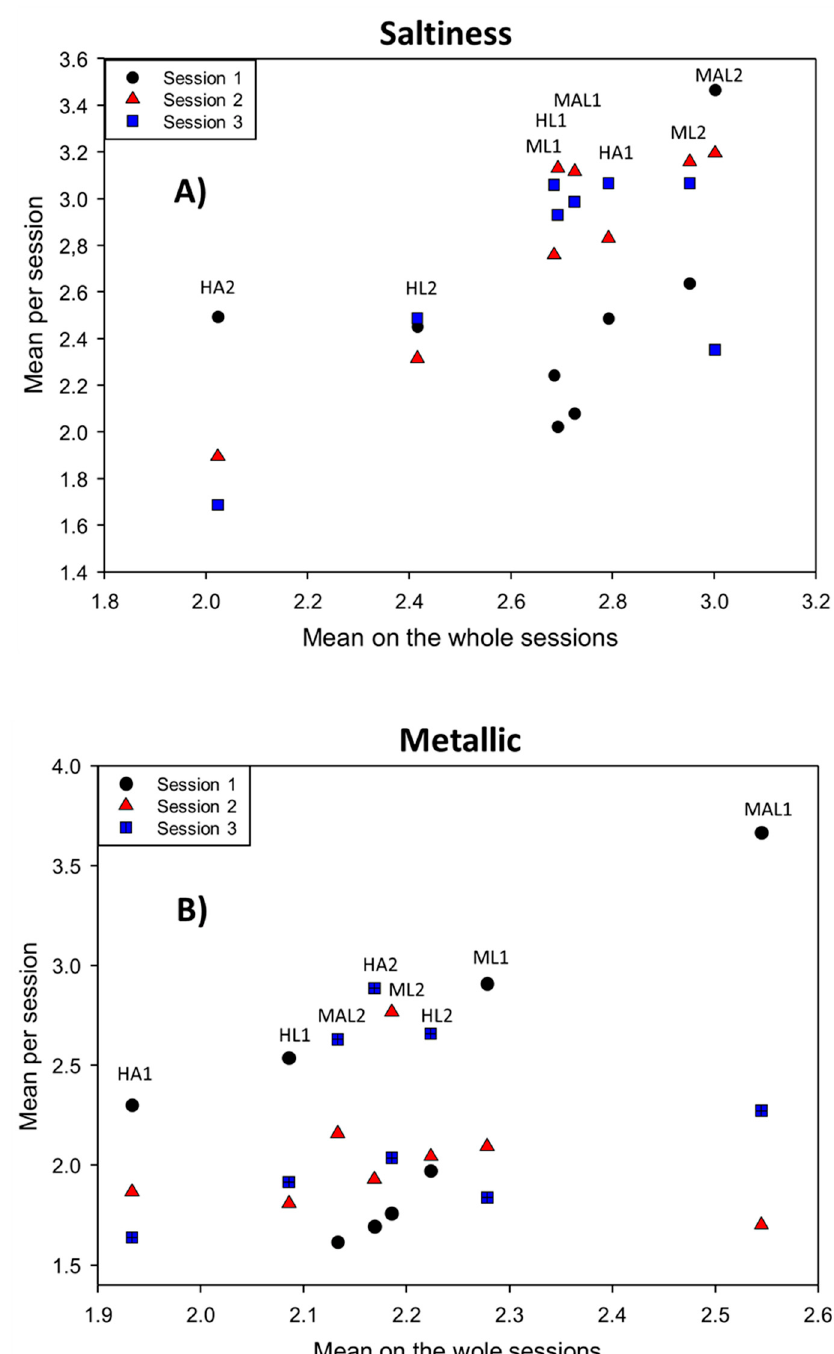
Figure 3. Panel performance. Sample · session interaction. Mean per session of panelists, according to samples, over the sample means of the whole sessions for significant descriptors: ( A ) saltiness, and ( B ) metallic.